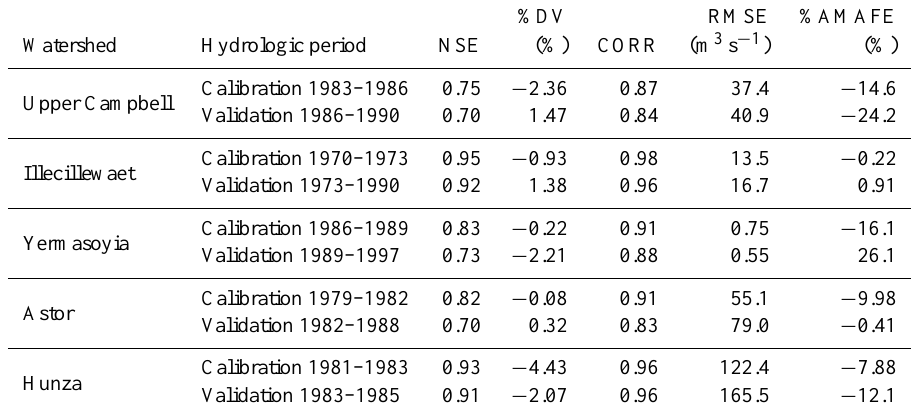
Table 7. Statistical indices of streamflow simulation with the classical methodology for poorly gauged watersheds – UBCCLA